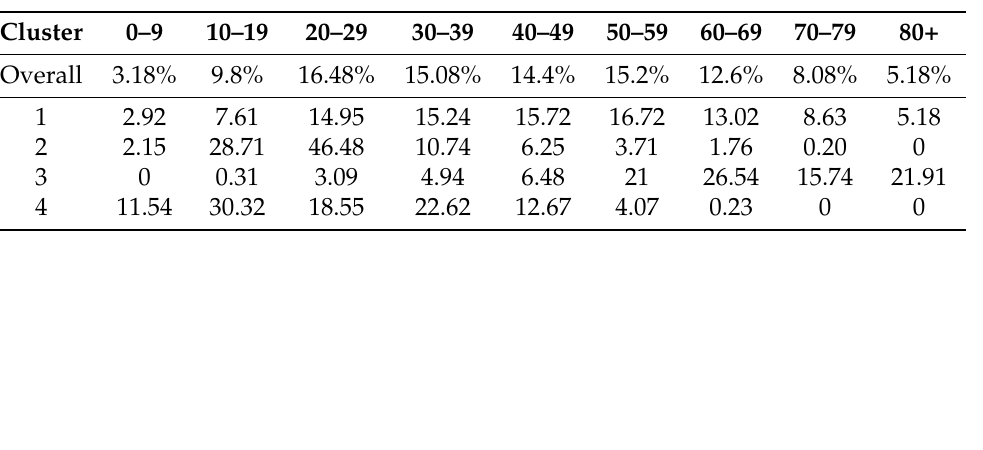
Table 6. Percentage of individuals who fall into age categories for overall sample of 10,000 and for each of the four clusters. Given as